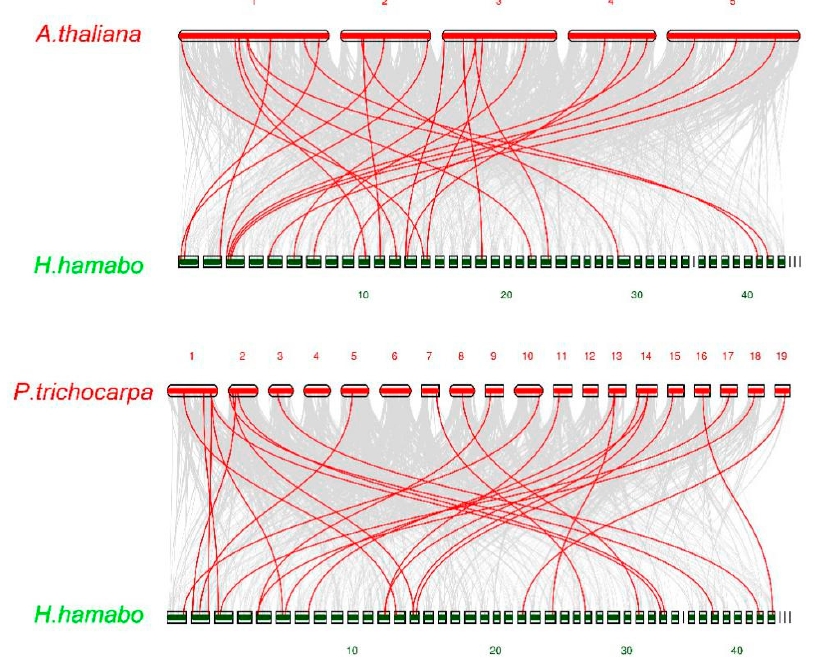
Figure 4. Synteny analysis maps of H. hamabo with A. thaliana and P. trichocarpa . Gray lines indicate the collinear blocks within H. hamabo and other plant genomes, whereas the red lines highlight the syntenic NAC gene pairs.